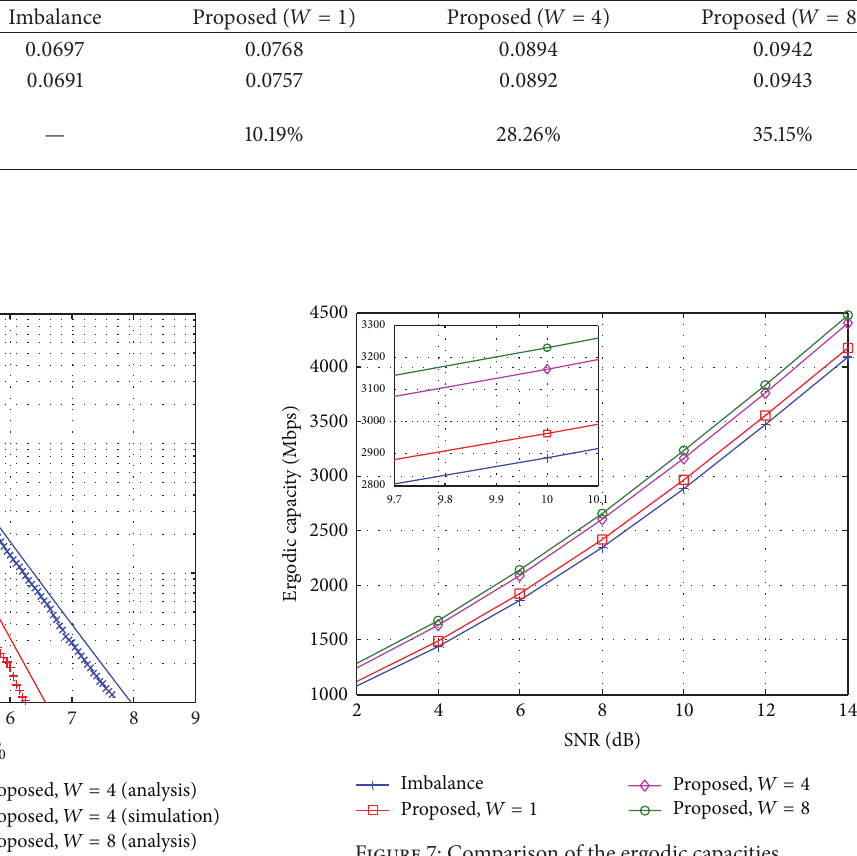
Figure 7: Comparison of the ergodic capacities. 𝜎 2 /𝜎 2 = 15 dB. As expected, the improvement in the power 𝑛 efficiency of HPAs results in an improved energy